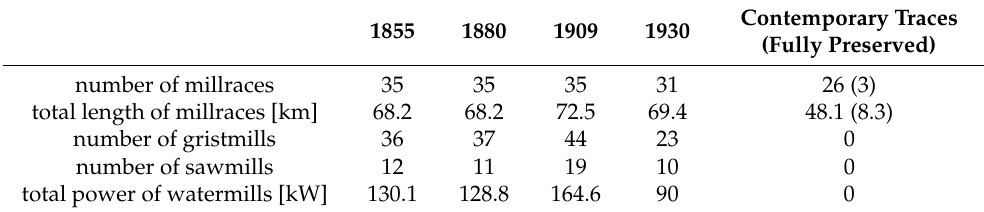
Table 5. General characteristics of millraces and the watermills located over them. 1855 1880 1909